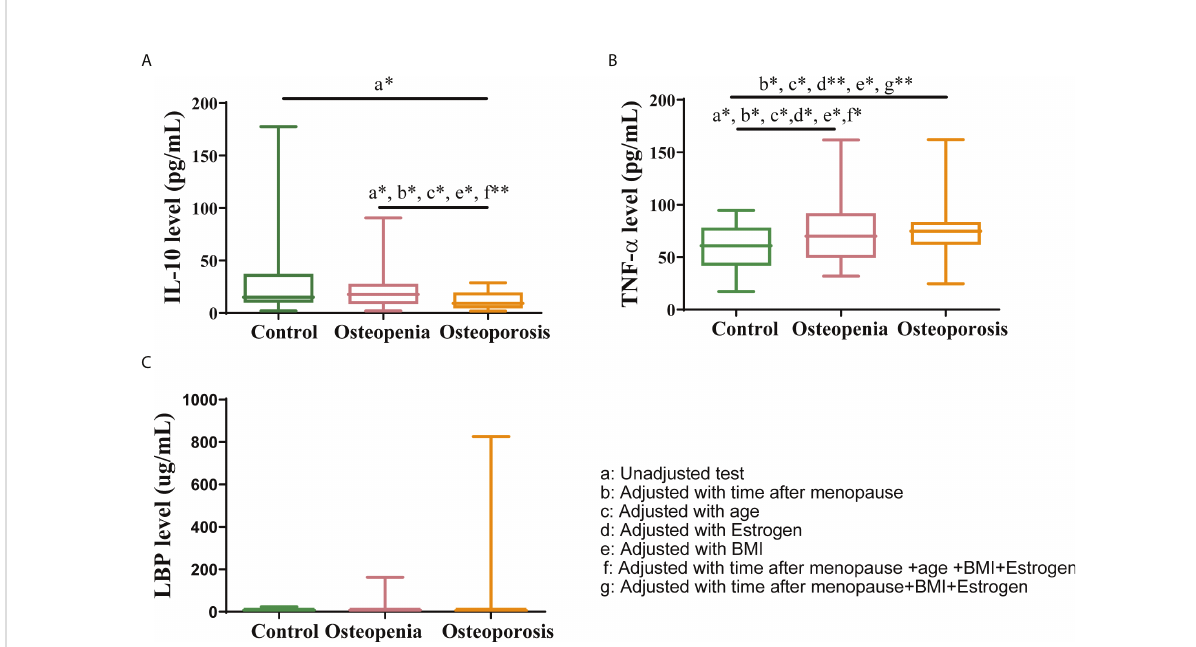
FIGURE 5 Changes in systemic in fl ammation status. Serum levels of (A) IL-10, (B) TNF- a and (C) LBP. The data have been presented as a box and whisker plot (vertical). The line in the middle of each box was plotted at the median, whereas the inferior and superior limits of the box correspond to the 25th and 75th percentiles, respectively. The whiskers correspond to the minimum to maximum values. A Kruskal – Wallis test was used to compare the differences among the three groups. Mann-Whitney U test was used to detect the differences among the two groups. All the covariates were adjusted using analysis of covariance (ANCOVA) by R package multcomp. * indicates p < 0.05, ** indicates p <